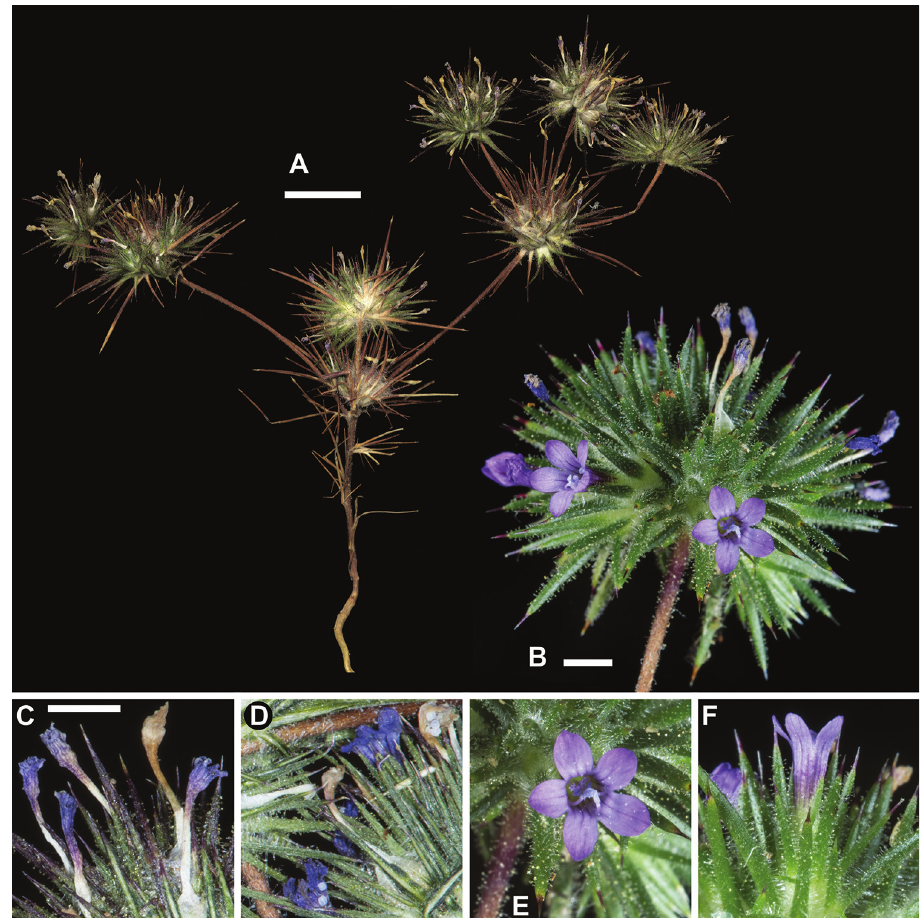
Figure 3. Navarretia vividior . A Pressed specimen showing plant habit, scale bar = 1 cm ( Johnson 16-066 ) B Flowering head in the field, scale bar = 2 mm ( Johnson 16-063b ) C–F Equivalent magnification, scale bar = 2mm C, D Pressed flowering head showing typical coloration of dried flowers and blue pollen ( Johnson 16-029, 16-063b, respectively) E, F Fresh flowers showing typical coloration ( Johnson 16-063b ). All photo- graphs by L. A. Johnson and vouchers deposited at